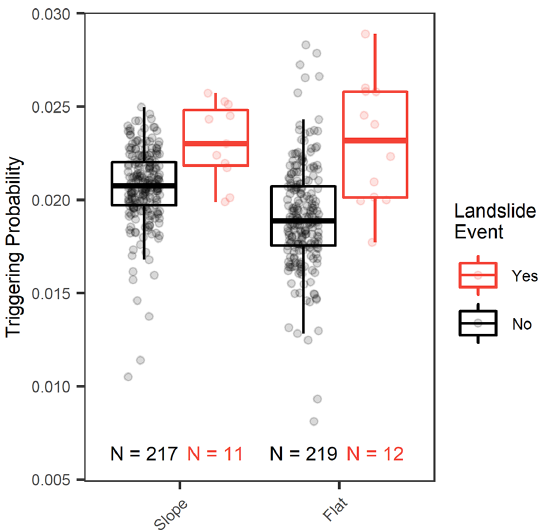
Figure 9. Boxplots showing the triggering probability distribution of infiltration events without (black) and with landslides (red) ap- plied to the sloped and flat site separately for a landslide forecast model based on the antecedent saturation and saturation change event properties and the 15km forecast distance. The number of infiltration events is indicated at the